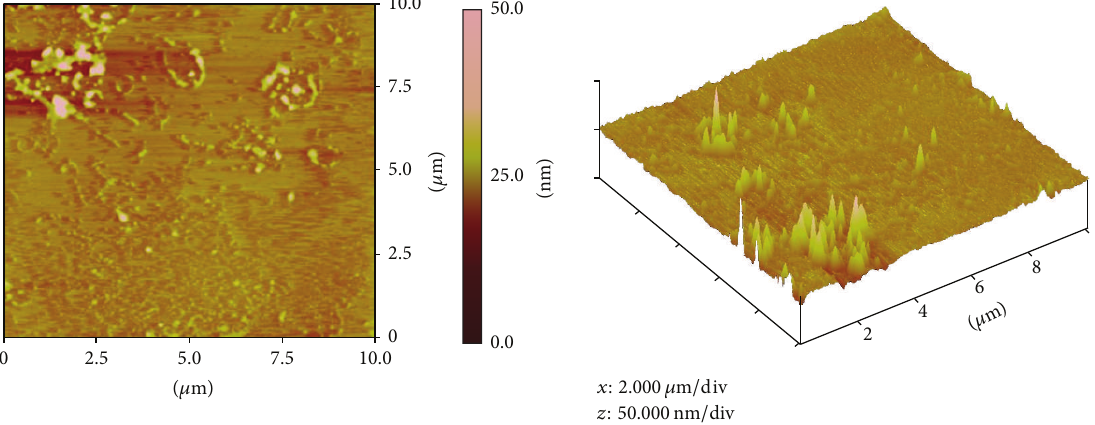
Figure 6: AFM plane height map and the three-dimensional topography (before cleaning).